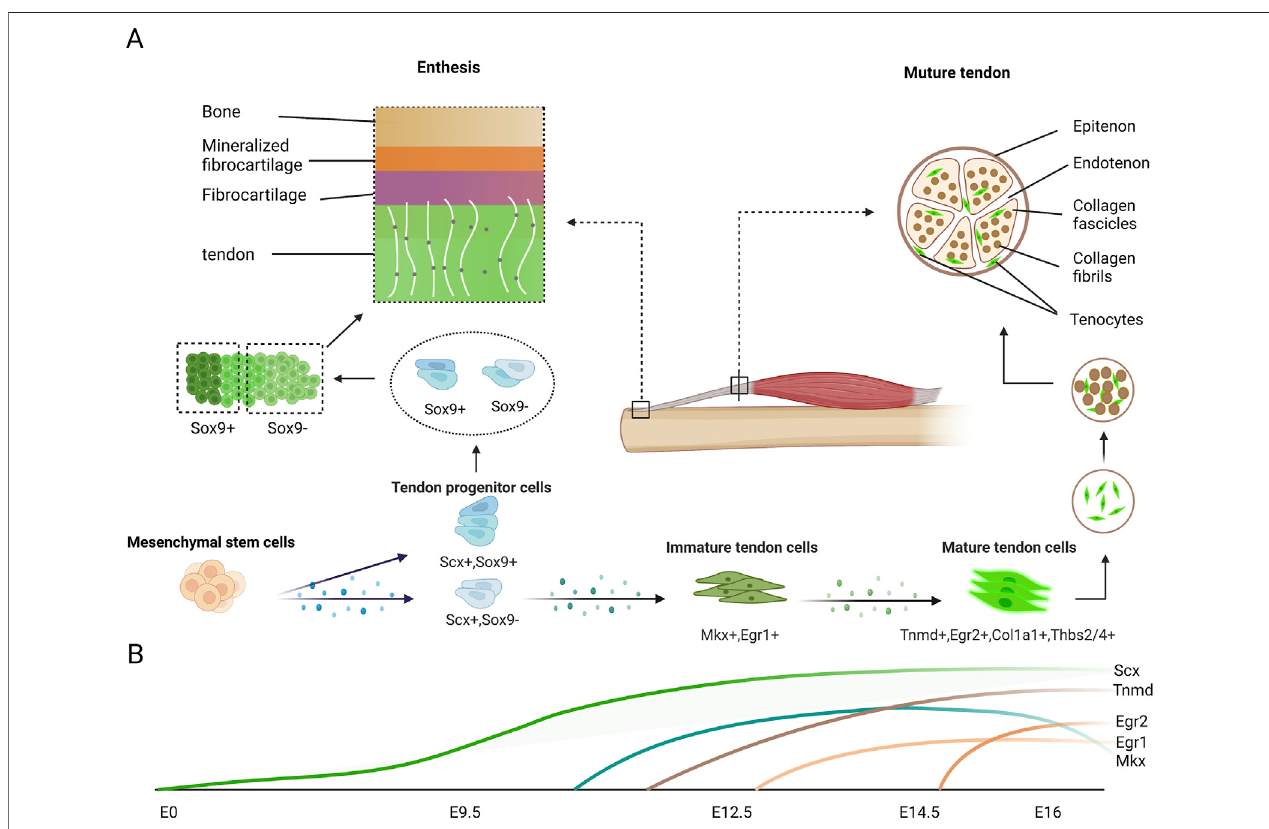
FIGURE 2 | Expression of tendon markers in tenocytes during tendon development. (A) Mesenchymal cells differentiate into Scx-expressing tendon progenitor cells,whichalsopartiallyexpressSox9.Scx + Sox9 + progenitorcellsdifferentiateintothetenocyteswhicharelocatedneartheboneintheenthesis.Otherprogenitorcells gradually express normal tendon markers during maturation. The classic enthesis is composed of four layers. From tendon to bone end are tendon layer, fi brocartilage layer, mineralized fi brocartilage layer and bone layer respectively. The mature tendon is composed by collagen fascicles which are assembled collagen fi brils, with sometenocytesattachedaround. (B) Inmouselimbs, Scx expressionbegintoincreaseatE9.5andcontinuetoincreaseuntiltenocytematuration.Slight Mkx expression is detectable in tendon at E12.5, after the emergence of Scx and robust Mkx mRNA expression at E13.5 and E14.5, stages at which the tendon progenitors undergo condensation and differentiation. Egr1 transcripts are fi rst expressed at E12.5 in Scx domains forming tendon, and they are expressed in long tendons at E16.5. Egr2 is fi rstdetectableinE14.5limbtendonsandisgenerallyexpressed inalllimbtendonsbyE16.5. Tnmd ishighlyexpressed inE14.5and isconsidered alatetendon marker.